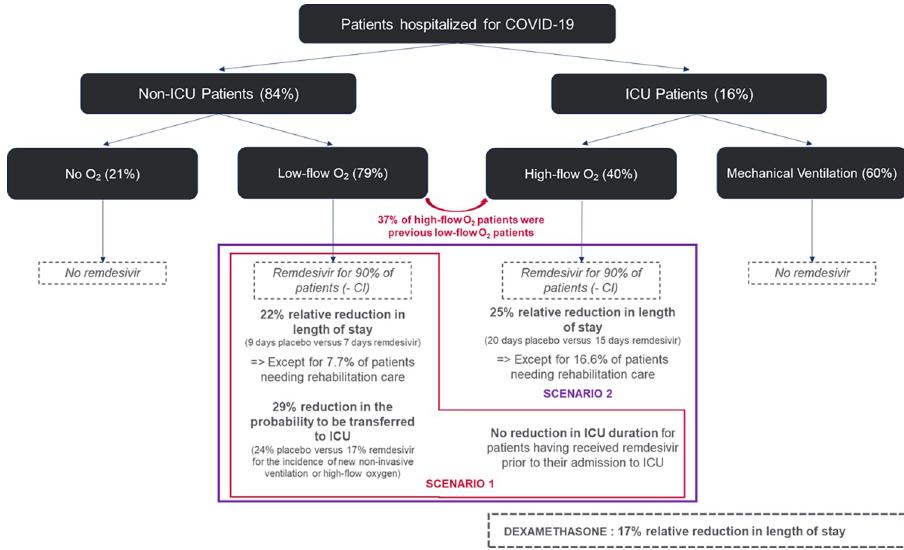
Fig 1. Probability tree diagram representing the patient